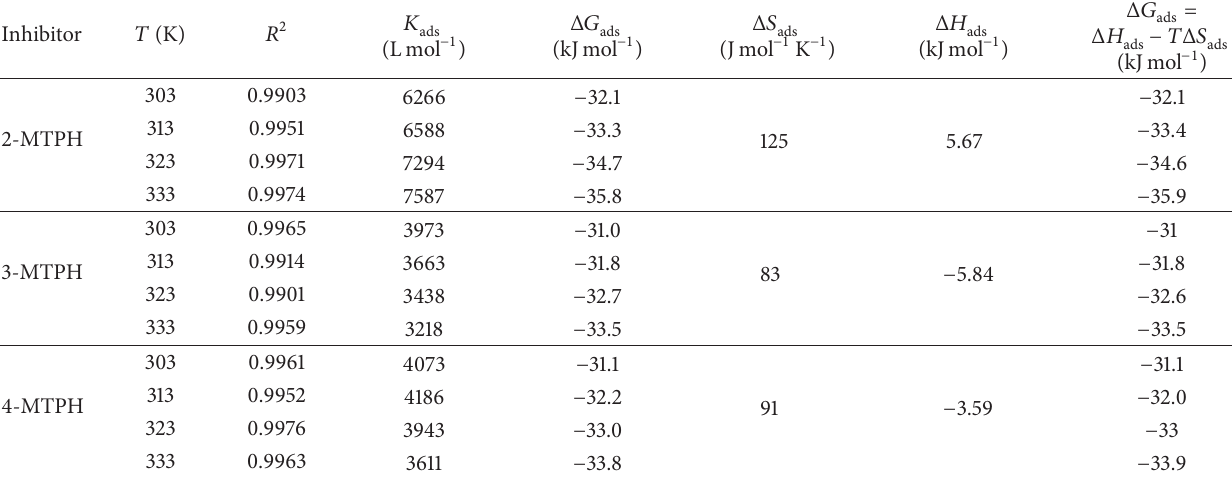
Table 4: Adsorption thermodynamic parameters in the absence and presence of various concentrations of